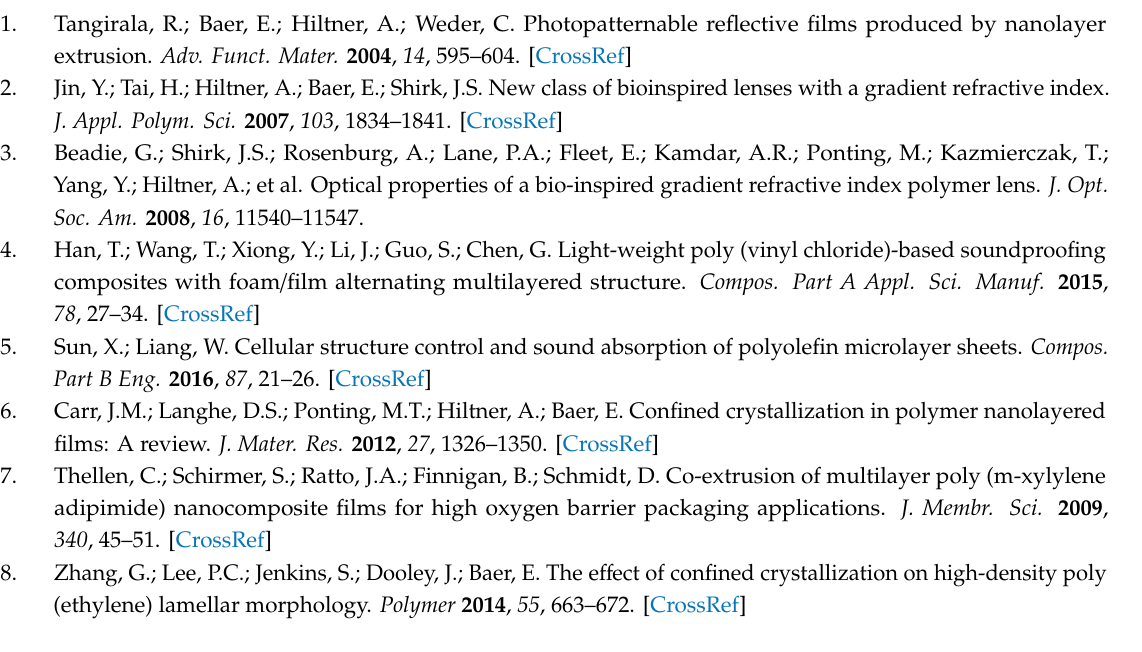
Figure S1. (a) Schematic representation of a single layer multiplier and (b) layer multiplication mechanism with an A-B-A inlet layer setting; Figure S2. Schematic representation of the MNL extrusion system: (1) nonwoven fiber mat, (2) twin-screw extruder, (3) heating zones, (4) layer multipliers, (5) extrudate.; Figure S3. First heating thermograms of PP / PET fibrillar blends with 3, 7, and 15 wt.% PET contents. Shaded region indicates the MNL extrusion processing window; Figure S4. Dynamic viscosity of PP at 200; Figure S5. An SEM image showing the exposed PET fibers after xylene etching and the angle of nanofiber orientation ( θ ) with respect to the MD (horizontal as